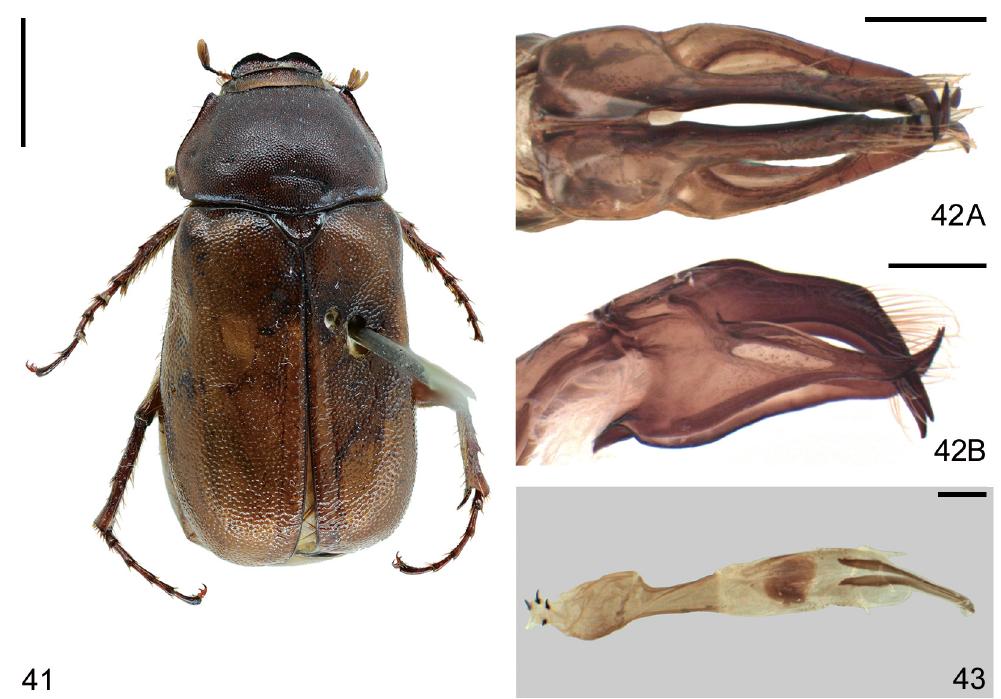
Figs 41–43. Miridiba hybrida (Moser, 1912) (non-type, BMNH). 41 . Habitus in dorsal view. 42 . Parameres in dorsal (A) and lateral (B) views. 43 . Endophallus (everted) and temones in dorsal view. Scale bars: 41 = 5.0 mm; 42–43 = 1.0